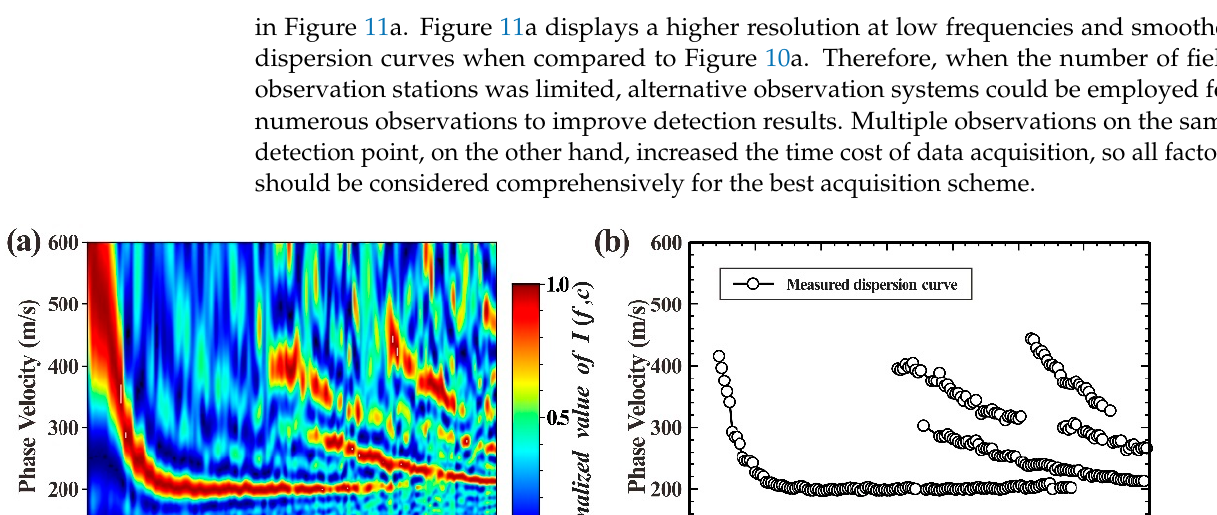
15 of 19 Figure 10. Rayleigh wave dispersion diagram extracted from measured array microtremor data us- ing frequency-Bessel transform method. ( a ) Observation system 1; ( b ) observation system 2. The station spacing and frequency were the only factors that affected the cross-cor- relation function 𝐶(𝑟, 𝜔) for the same stratigraphic structure. Using various observation